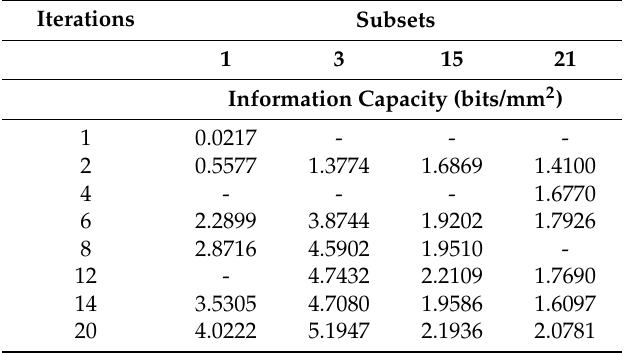
Table 1. Information capacity values for different subsets/iterations.